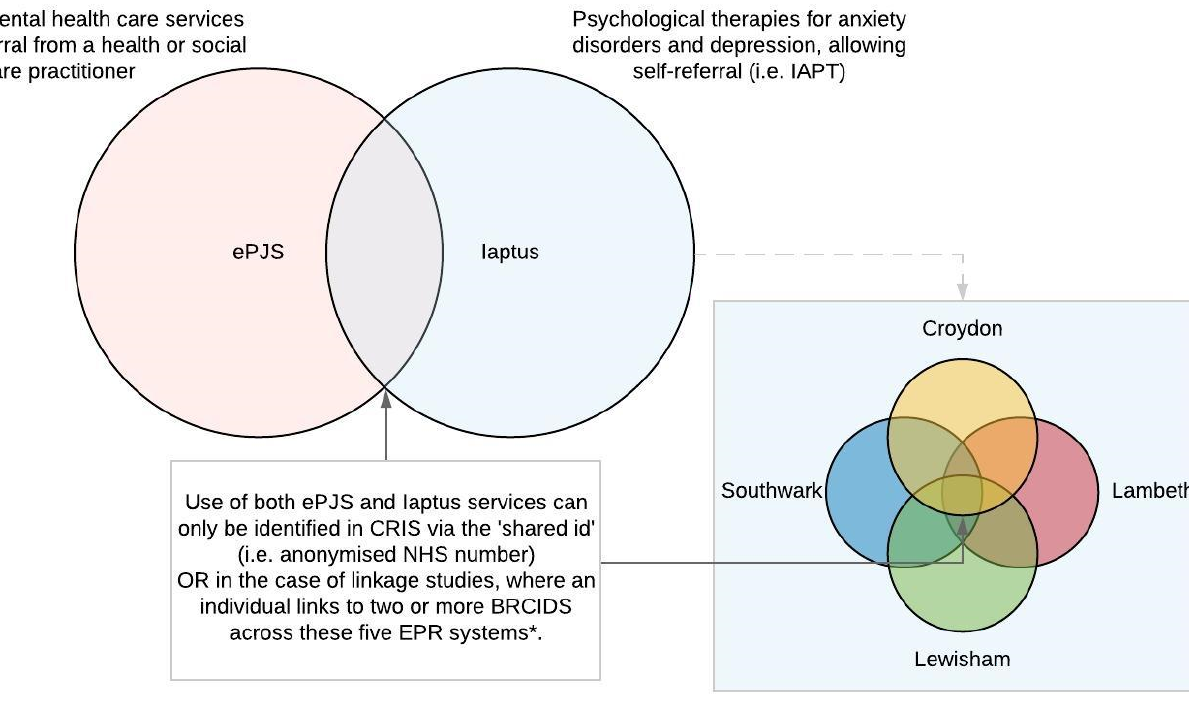
Figure 1: The five electronic patient record systems that feed into the CRIS